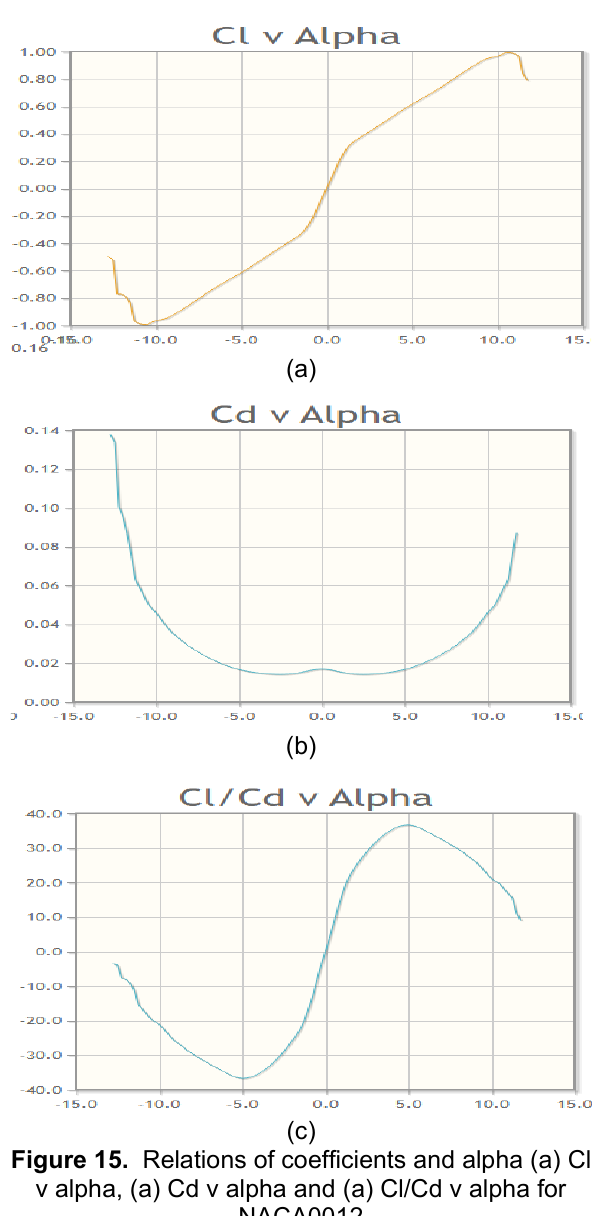
Figure 15. Relations of coefficients and alpha (a) Cl v alpha, (a) Cd v alpha and (a) Cl/Cd v alpha